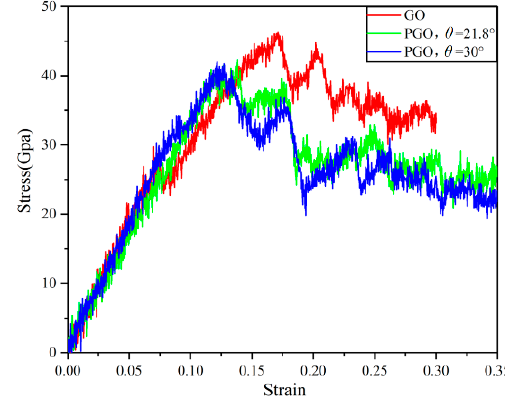
Figure 7. Uniaxial tensile stress-strain curves at R = 30%.